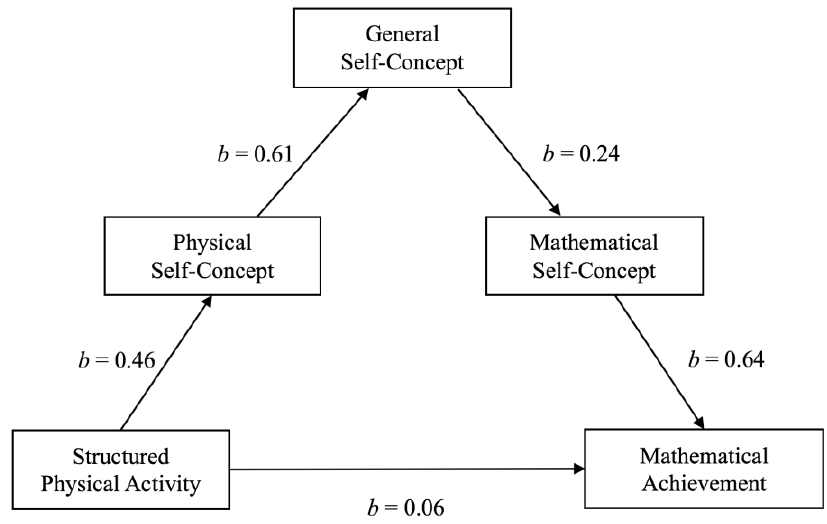
Figure A1. Evidence for the rationale behind the mediation by self-concept.